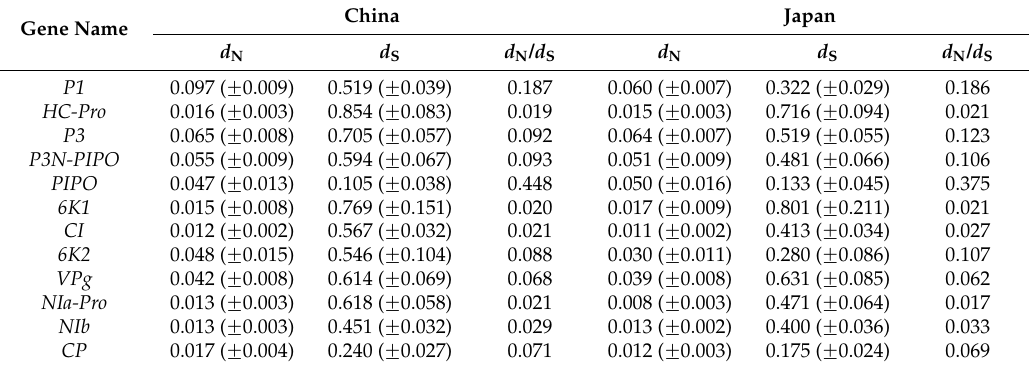
Table 6. Nucleotide diversity of each coding gene of TuMV isolates collected from China and Japan. Gene Name